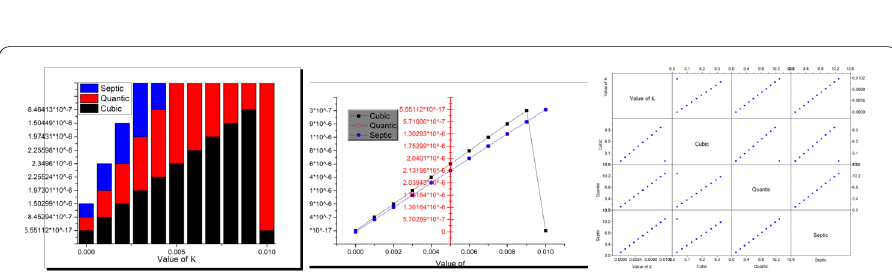
Figure 6 A comparison representation of absolute value of error of Eq. (2) according to the obtained values via cubic, quantic, and septic B-spline